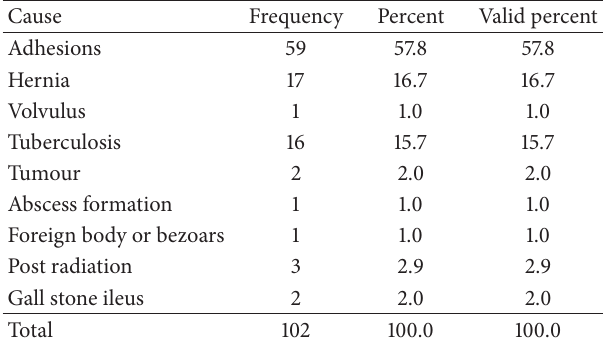
Table 1: Cause of small bowel obstruction in the study